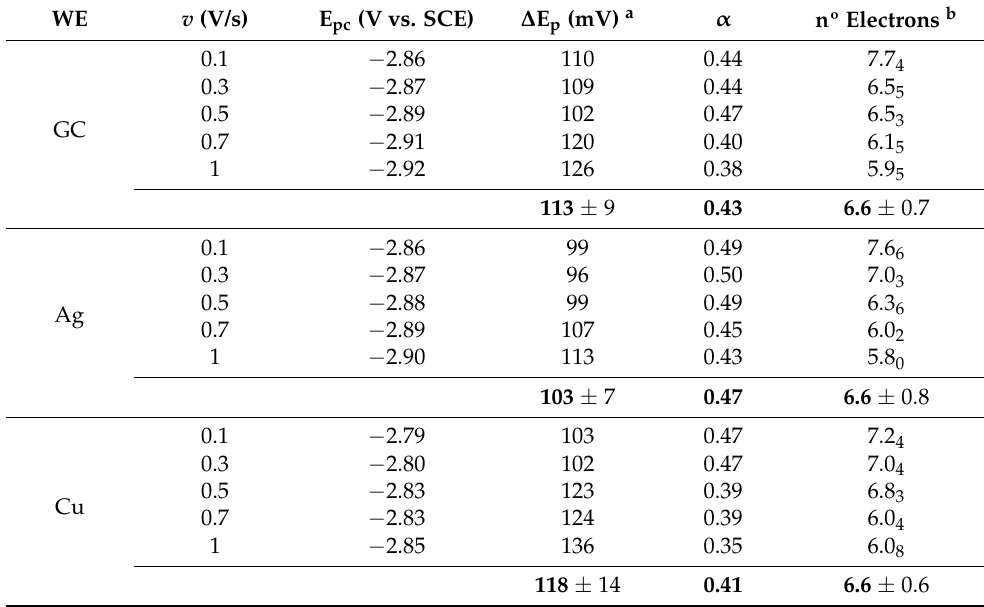
Table 3. Electrochemical parameters for a solution of 24 mM of 1 in BMPyr TFSI, using as a